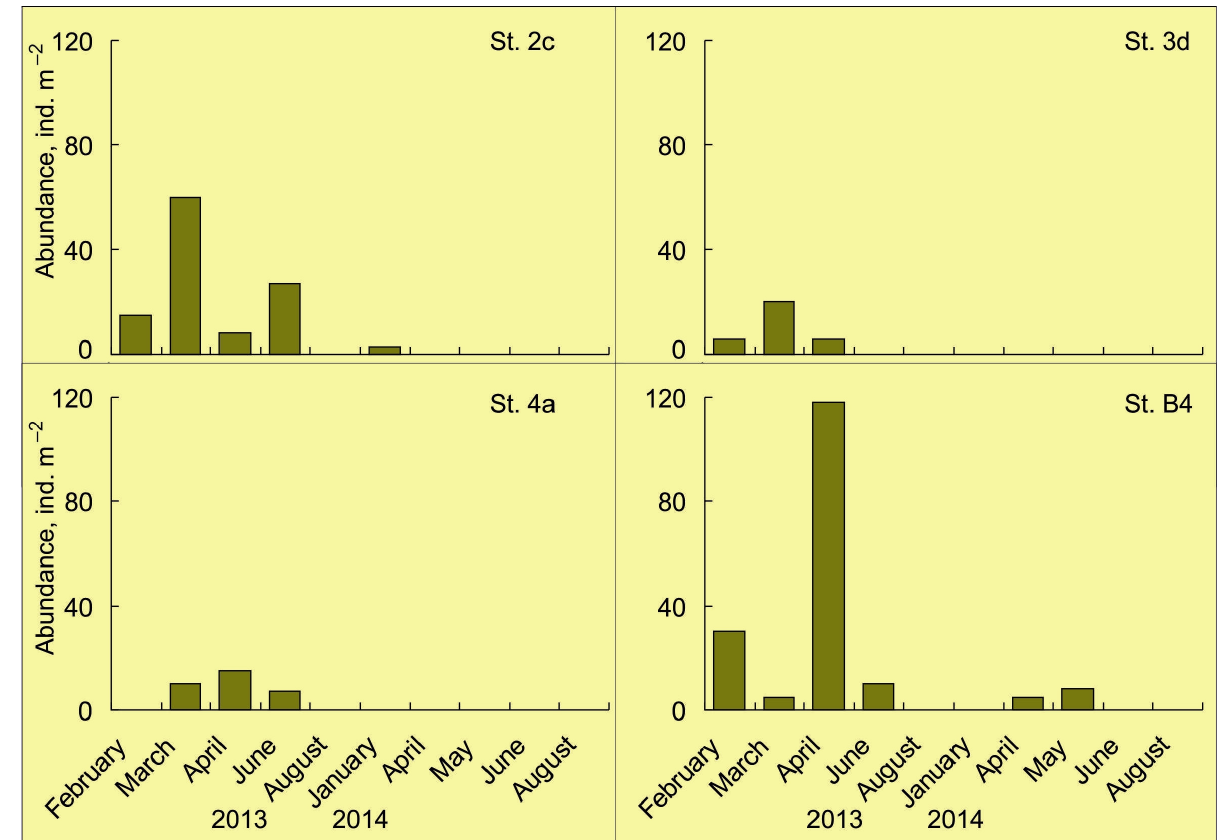
Figure 9. Seasonal abundance (individuals m −2 ) of red king crab larvae at different stations (see Figure 8) in Norwegian waters of the Barents Sea (Porsangerfjord) (modified from [87]).